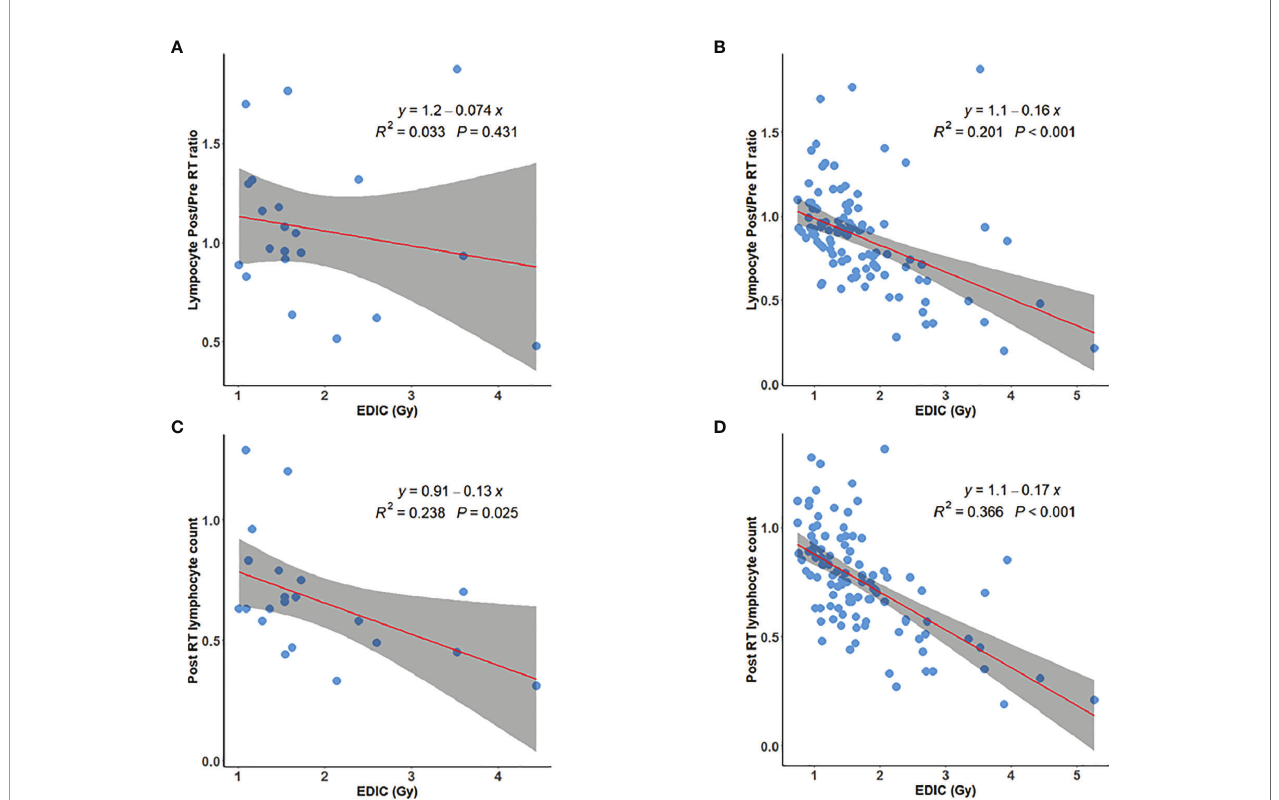
FIGURE 3 | Post/preRT PLC ratio versus EDIC for (A) 21 patients with grade-2+ preRT lymphopenia; (B) 105 patients with grade-1+ preRT lymphopenia; PostRT PLC versus EDIC for (C) 21 patients with grade-2+ preRT lymphopenia; and (D) 105 patients with grade-1+ preRT lymphopenia.